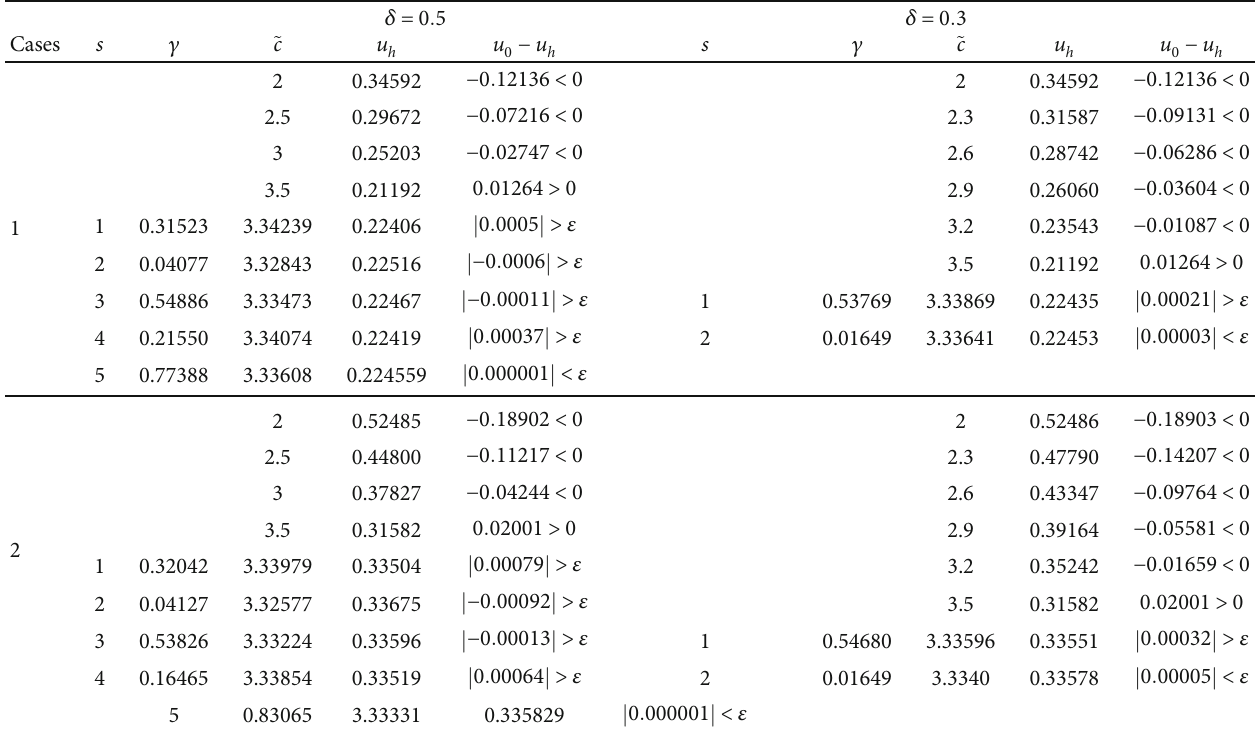
Table 6: With ε = 10 − 4 precision, using the bisection method, obtained solutions u and 2 ( s is the number of iterations).